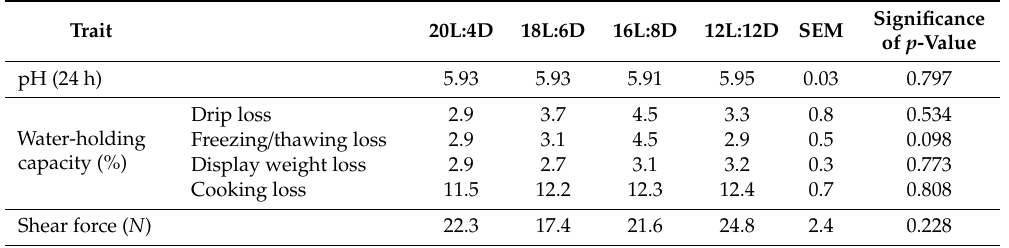
Table 2. E ff ect of photoperiod on pH, water-holding capacity, and instrumental shear force of broiler fillet ( M. Pectoralis major ) muscles ( n = 6 / treatment).